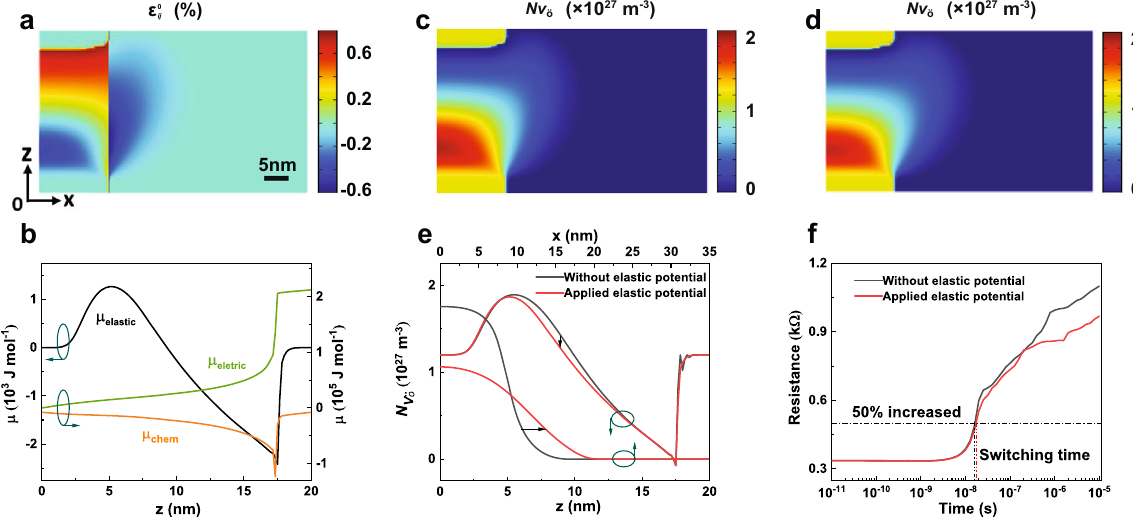
Fig. 2 Effect of V ö -induced mechanical strain on the V ö migration and resistive switching behavior. a 2D map of the oxygen vacancy induced elastic strain in reset state, b 1D pro fi les of the elastic, electrical and chemical potential along the center of CF ( x = 0, z = 0 – 20 nm), c and d 2D maps of oxygen vacancy density N V without and with coupling the mechanical effect during reset process, e comparison of 1D € O along the center of the CF ( x = 0, z = 0 – 20 nm) and the cylindrical direction ( z = 10 nm, x = 0 – 35 nm) with and without coupling pro fi les of N V € O the mechanical effect, f the evolution of total resistance under a constant applied voltage of 1.1 V during reset process. The switching time ( t switch ) is de fi ned by a 50% increase with respect to the initial resistance value. The scale bar in a applies to c and d